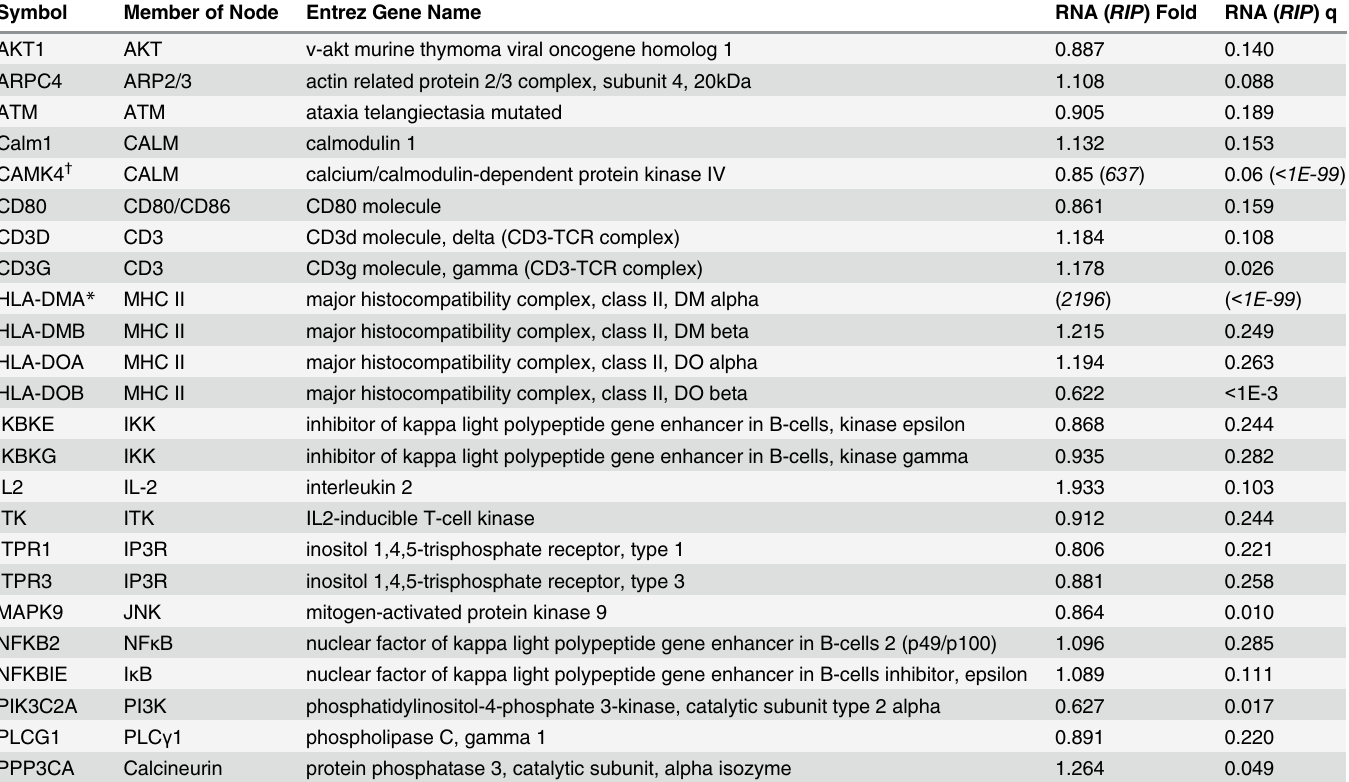
Table 6. Details of the hits of canonical pathway CD28 Signaling in T Helper Cells. Official symbols of the significant genes found via RNA-Seq (RIP-- Seq) that are in the pathway (Fig 3) is given along with the name of its corresponding node in the pathway. Fold is given as KO/CTL (RNA-Seq) or IP/CTL (RIP-Seq), and q is the false discovery rate value based on method of Benjamini-Hochberg. Genes were identified by both RNA-Seq and RIP-Seq. Numbers in parentheses and italicized denote data obtained from